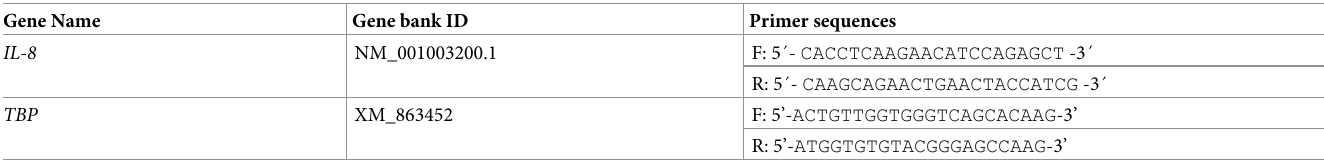
Table 1. Primer sequences for